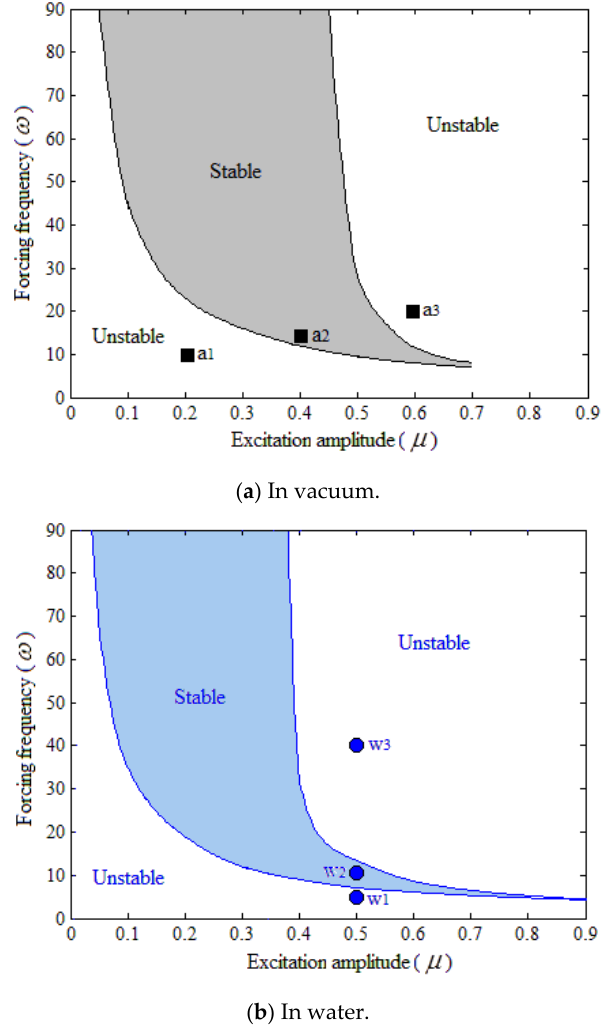
Figure 4. Stability regions for inverted pendulum systems ( a ) in vacuum and ( b ) in water.